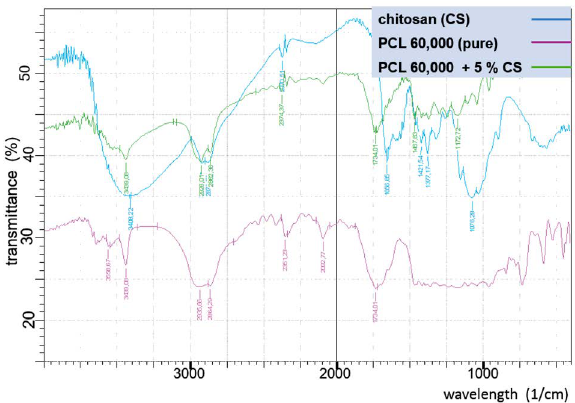
Figure 3. The FTIR spectra of raw materials (PCL (Mw = 60,000 g/ mol) and CS) and the composite